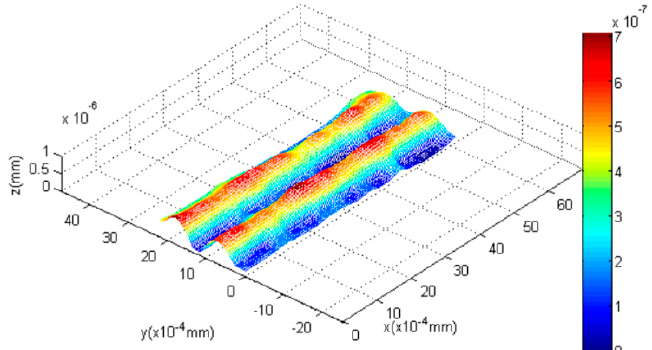
Figure 9. The reconstructed shape of the grid.